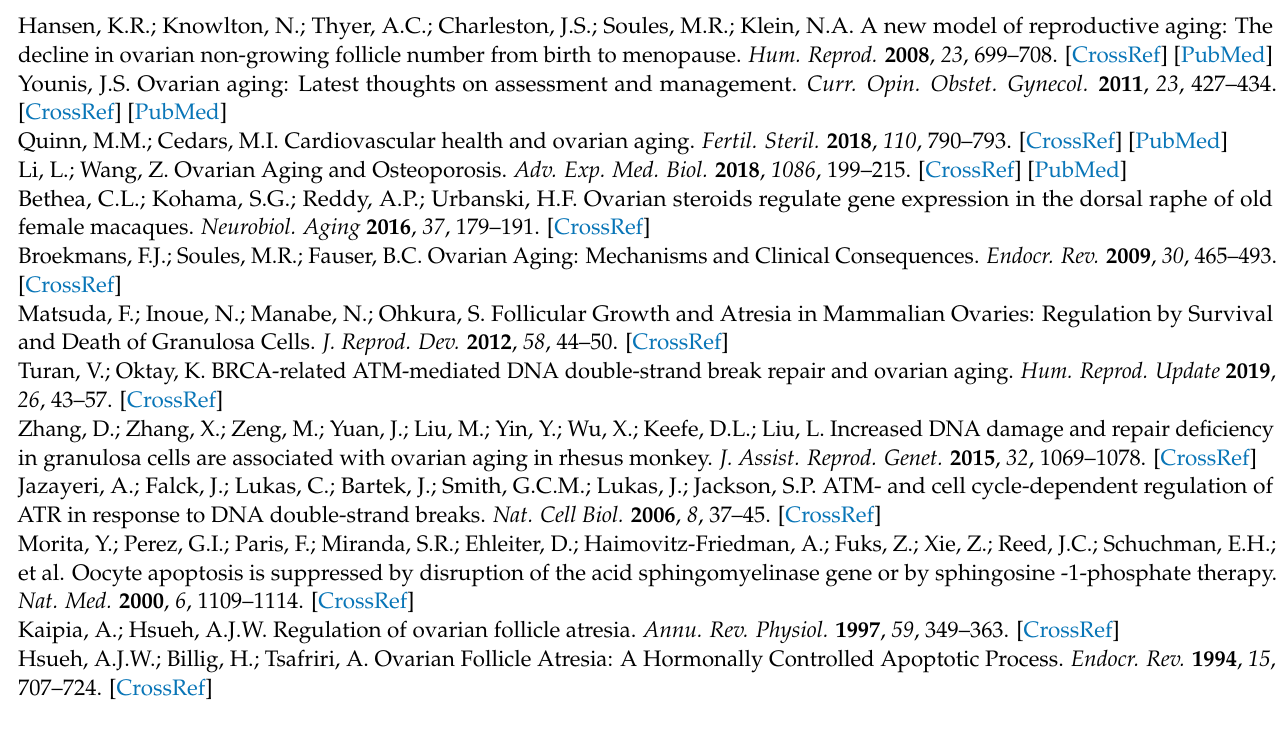
Figure S2: The original images of the Western blot experiments for Figure 4C. Figure S3: The original images of the Western blot experiments for Figure